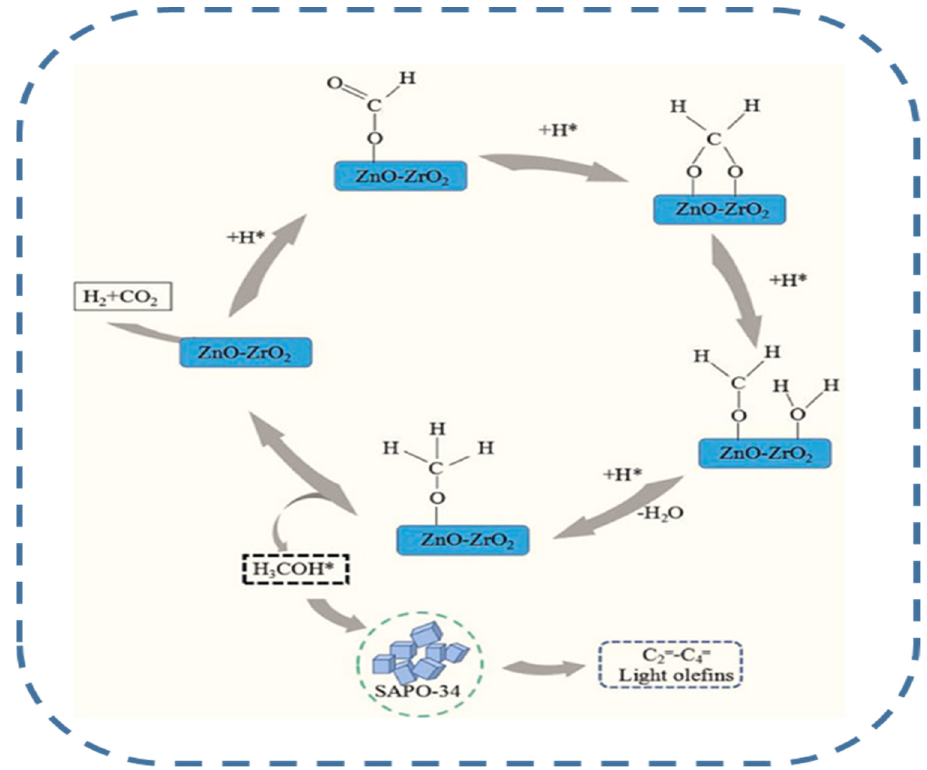
Figure 17. Mechanism of CO 2 activation on the surface of the 13%ZnO–ZrO 2 component of the 13%ZnO–ZrO 2 /Mn–SAPO-34 catalyst. Reproduced from [126] with copyright license from Elsevier (2021).